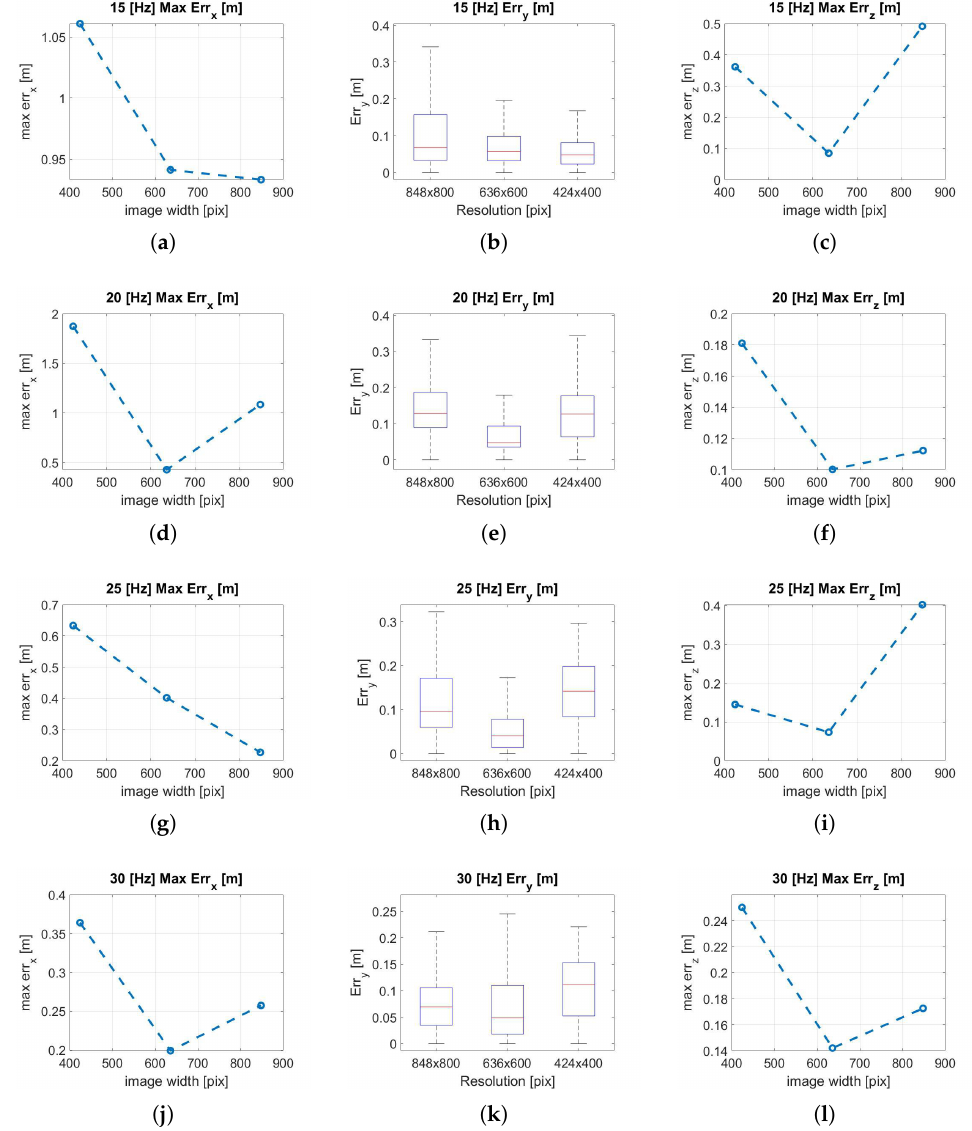
Figure 10. ( a ) X max error, 15 Hz; ( b ) Y error, 15 Hz; ( c ) Z max error, 15 Hz; ( d ) X max error, 20